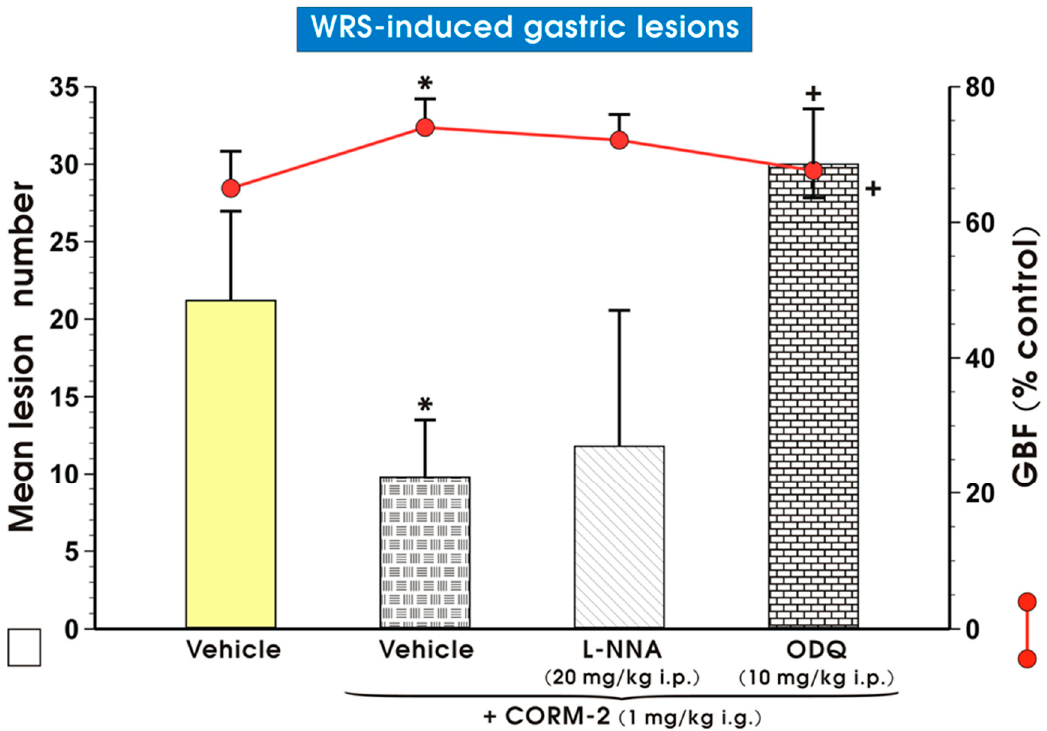
Figure 4. Mean lesion number and gastric blood flow (GBF) in gastric mucosa pretreated i.g. with vehicle (saline; yellow pattern), carbon monoxide releasing molecule 2 (CORM-2, 1 mg/kg i.g.) applied alone (mosaic pattern) or in combination with N G -nitro- L -arginine ( L -NNA, 20 mg/kg i.p.; line pattern) or 1H-[1,2,4]oxadiazolo[4,3-a]quinoxalin-1-one (ODQ, 10 mg/kg i.p.; brick pattern) and followed by water immersion and restraint stress (WRS). Results are mean ± S.D. of 6–8 animals for each experimental group. Asterisk indicates significant change ( p < 0.05) as compared with vehicle (saline). Cross indicates significant change ( p < 0.05) as compared with the group pretreated with vehicle (saline) and administered with CORM-2 (1 mg/kg i.g.).